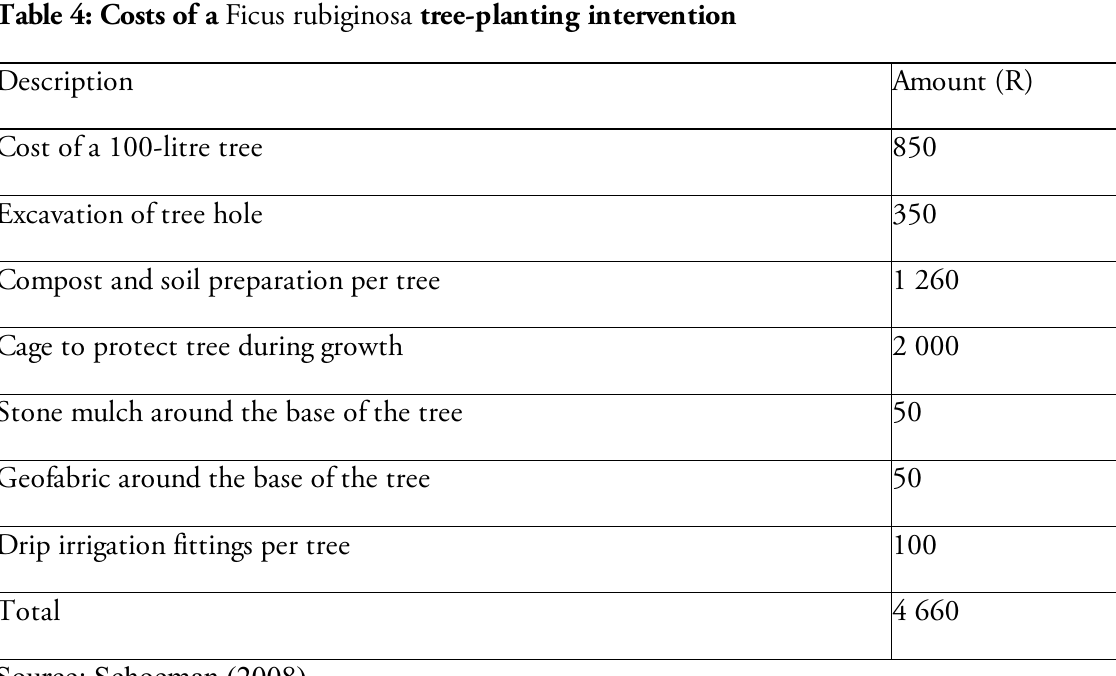
Table 4: Costs of a Ficus rubiginosa tree-planting intervention